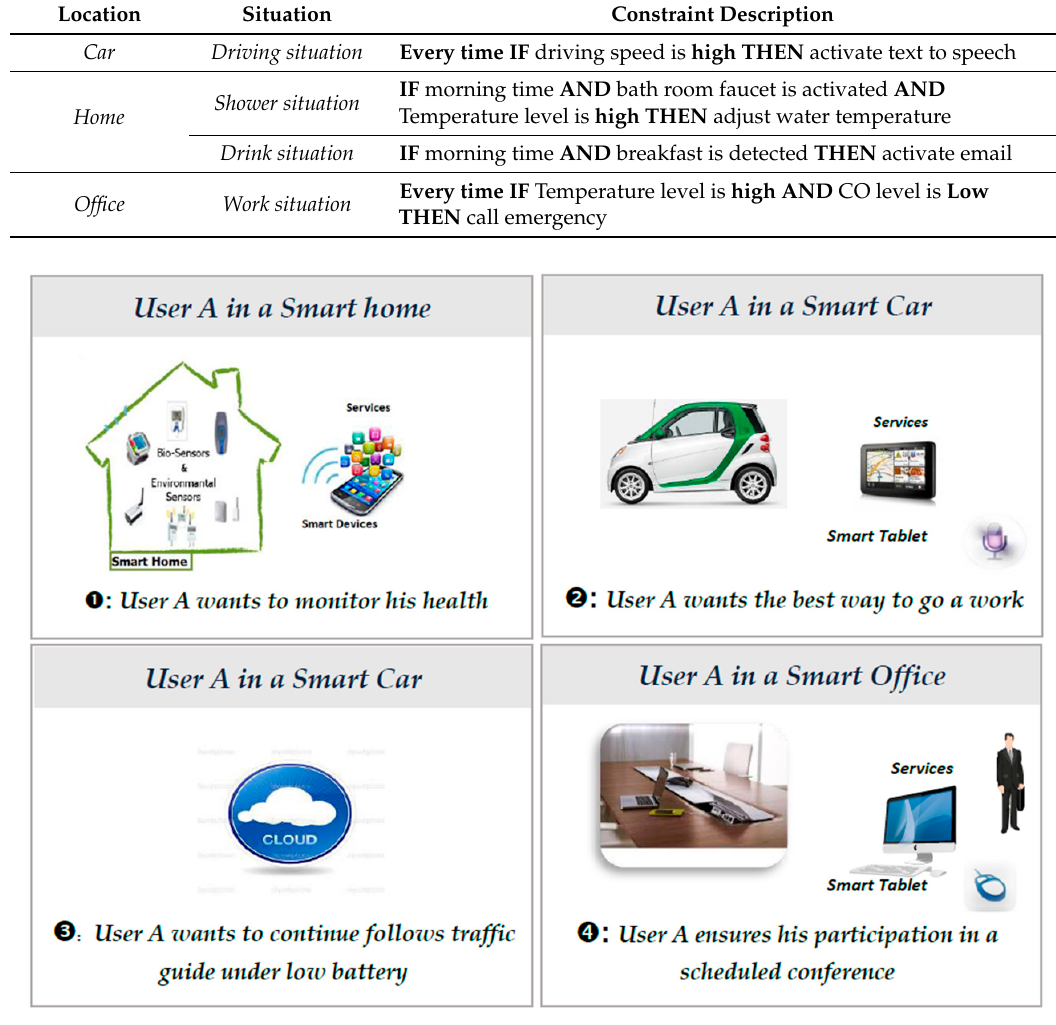
Figure 17. Potential scenarios.